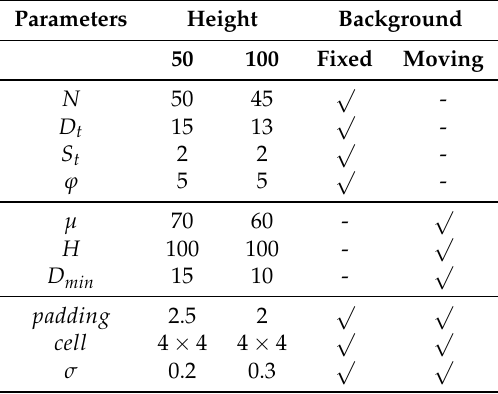
Table 2. Parameter